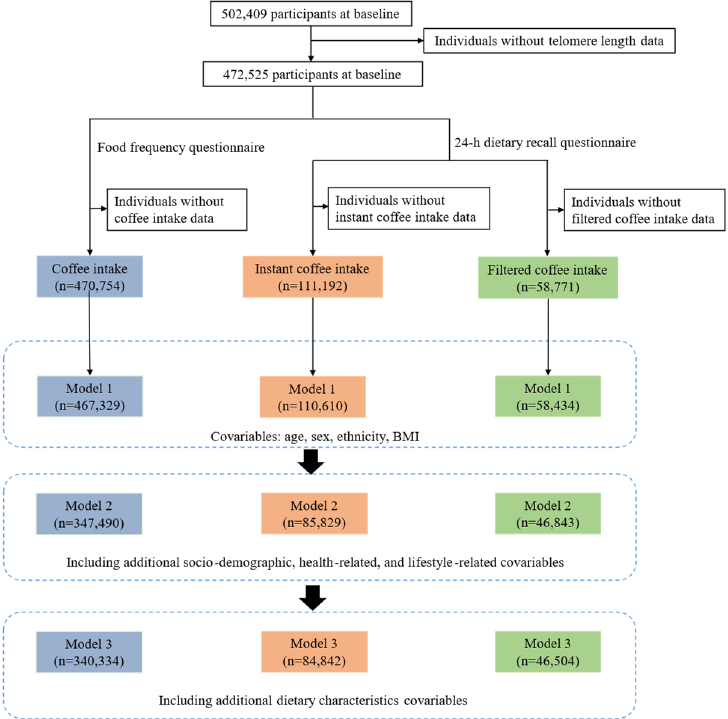
Figure 1. Flowchart of study participants.